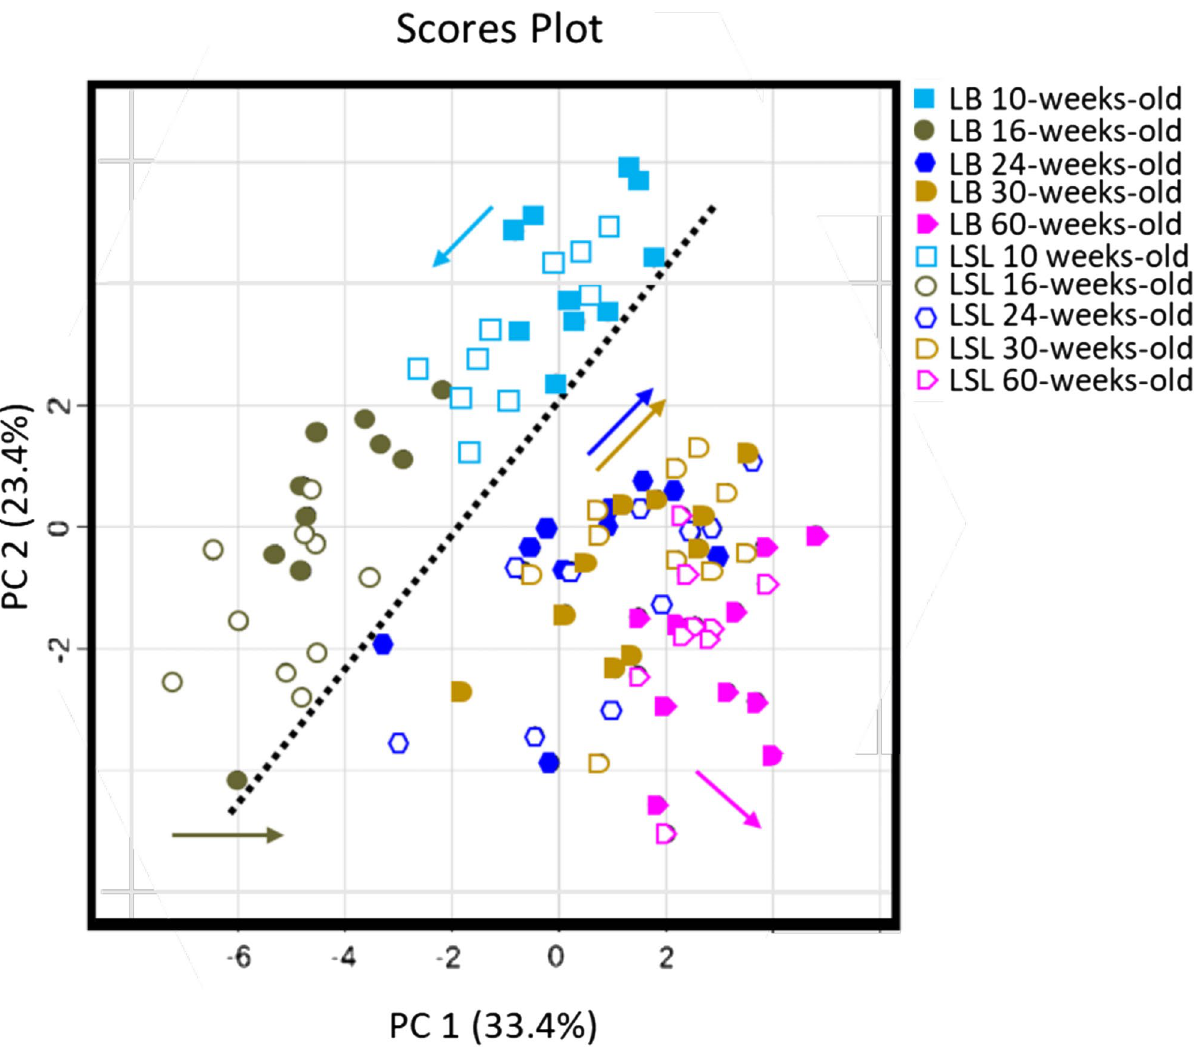
Figure 2. Principal component analysis (PCA) of plasma metabolite profiles of LB and LSL hens determined at five production periods. Each point indicates metabolite profile of one hen and each color indicates one specific period of production. Filled symbols indicate LB hens whereas open symbols indicate LSL hens. Dashed line indicates a clear separation between hens before and after laying-egg period. Color arrows show the direction of shifting according to each stage of